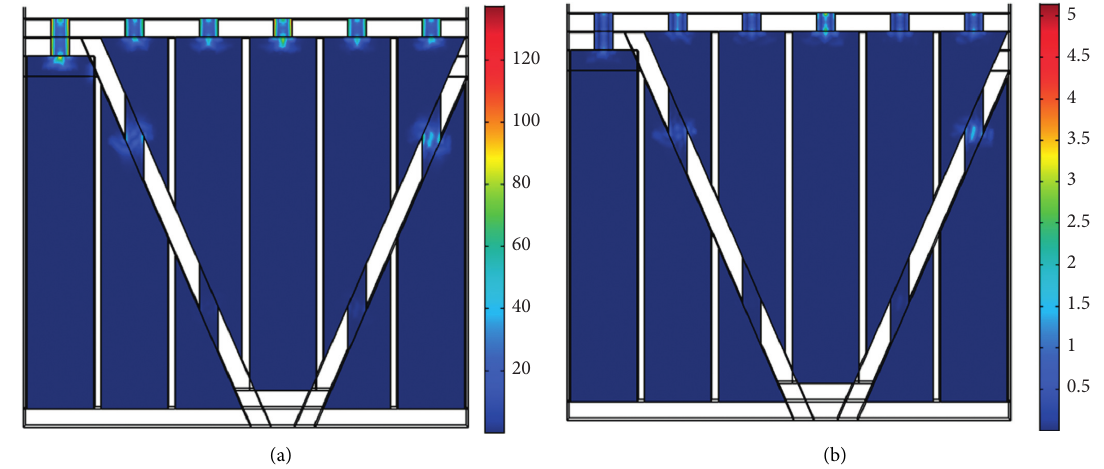
Figure 7: Total thermal-viscous dissipation of rubber 2 at (left) 105 and (right)